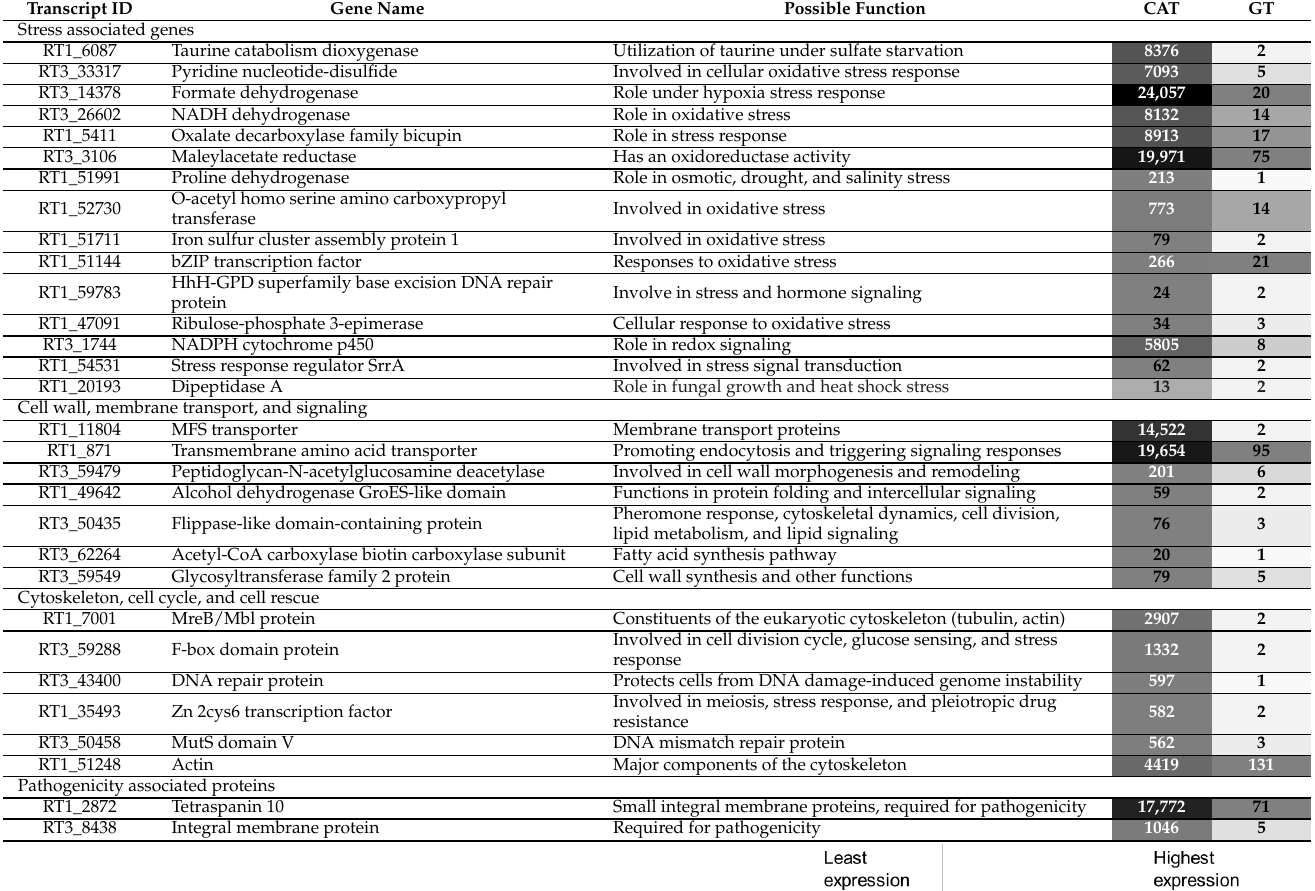
Different shades of colors (white, grey and black) represent expression of GT and CAT